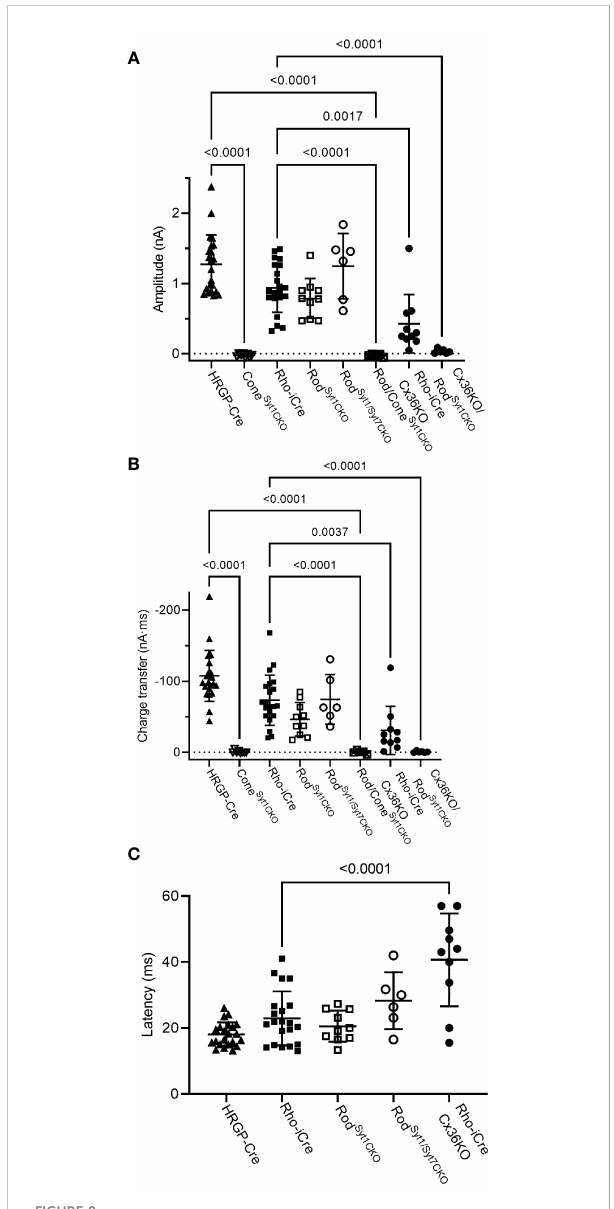
FIGURE 8 Summary of optogenetically-evoked responses in RGCs from different genotypes. (A) Response amplitude evoked by stimulation of rods or cones were both reduced signi fi cantly by elimination of Syt1 from cones. Eliminating Syt1 from rods did not signi fi cantly reduce responses evoked by optogenetic stimulation of rods. Eliminating Cx36 also signi fi cantly reduced responses evoked by optogenetic stimulation of rods. Residual responses in Cx36KO mice were abolished by eliminating Syt1 from rods. (B) Charge transfer measurements in the same cells showed similar effects. (C) Latency measurements showed that eliminating Cx36 lengthened the average latency of responses evoked by optogenetic stimulation of rods. Latencies were not measured in the three experimental conditions where responses were abolished. This included both genotypes lacking Syt1 in cones as well as Cx36KO retinas lacking Syt1 in rods. Cone Syt1CKO , n = 8 cells (6 mice); Rod Syt1CKO , n = 10 cells (7 mice); Rod Syt1Syt7CKO , n = 6 cells (2 mice); Rod/Cone Syt1CKO , n = 5 cells (5 mice); Rho-iCre/Cx36KO, n = 10 cells (3 mice). Experiments in this fi gure were conducted in the presence of strychnine (1 m M) and picrotoxin (100 m